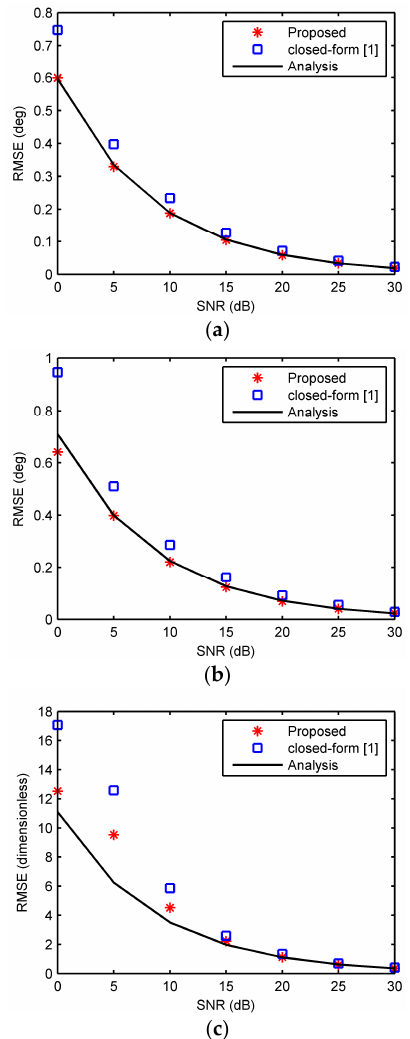
Figure 3. RMSE against signal-to-noise ratios (SNRs). ( a ) The elevation angle; ( b ) the azimuth angle; ( c ) the range.